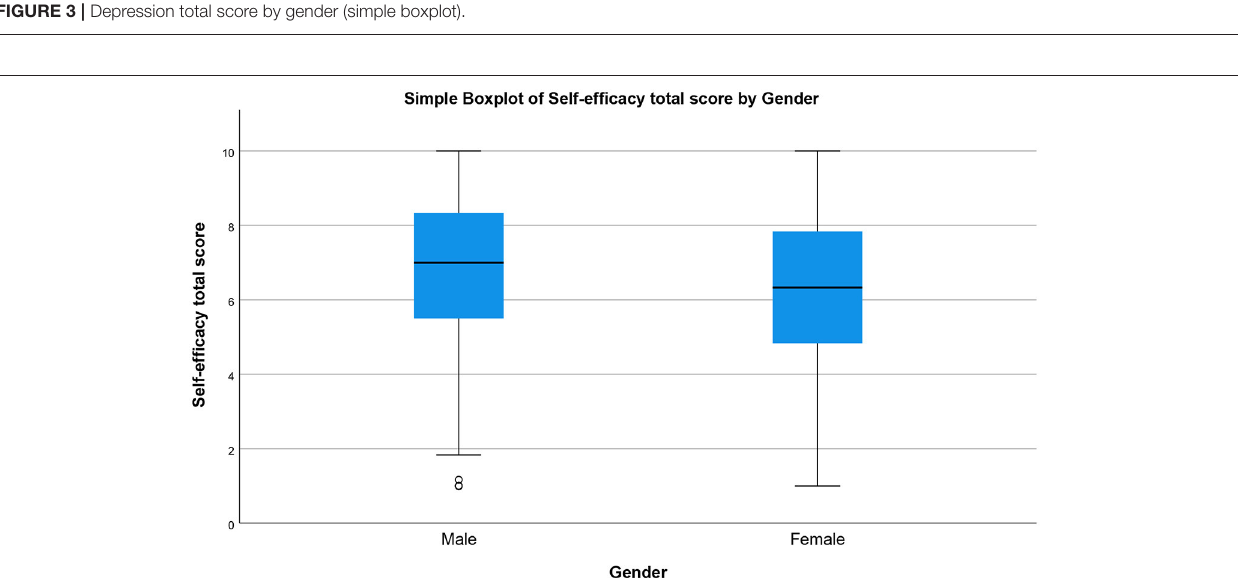
FIGURE 3 | Depression total score by gender (simple boxplot).